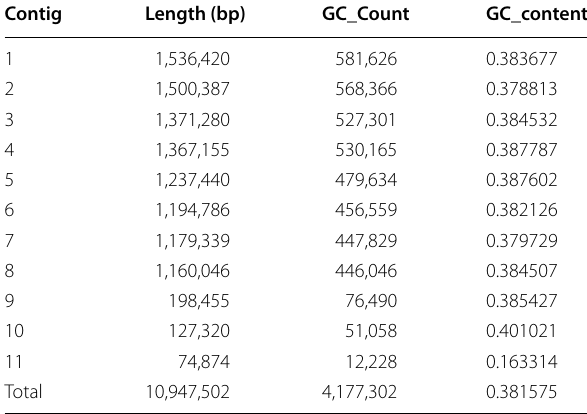
Table 2 Lengths and GC contents of contigs